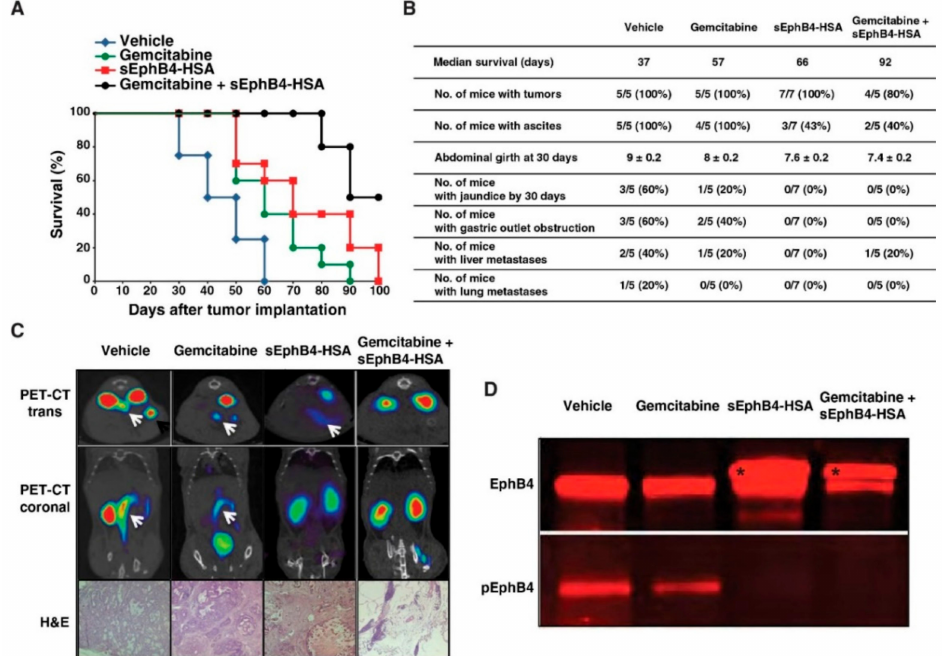
Figure 6. sEphB4 inhibits tumor growth and metastasis in an orthotopic tumor model. CAPAN-1 cells were orthotopically implanted into the pancreas of athymic mice to establish tumors. Mice were randomized into four groups and treated by intraperitoneal injection of PBS, sEphB4-HSA (20 mg/kg, thrice a week), gemcitabine (10 mg/kg, twice a week), and a combination of sEphB4-HSA and gemcitabine: ( A ) The survival results of the study (terminated at day 100); ( B ) Pathological analysis summary of the mice at the end of the study; ( C ) Representative PET-CT scan pictures. Tumors are indicated with white arrows. Representative H&E staining pictures of the pancreas are shown at the bottom; ( D ) Expression of EphB4 and its phosphorylation. EphB4 phosphorylation was inhibited by sEphB4-HSA treatment in the tumor as compared to vehicle-treated samples.